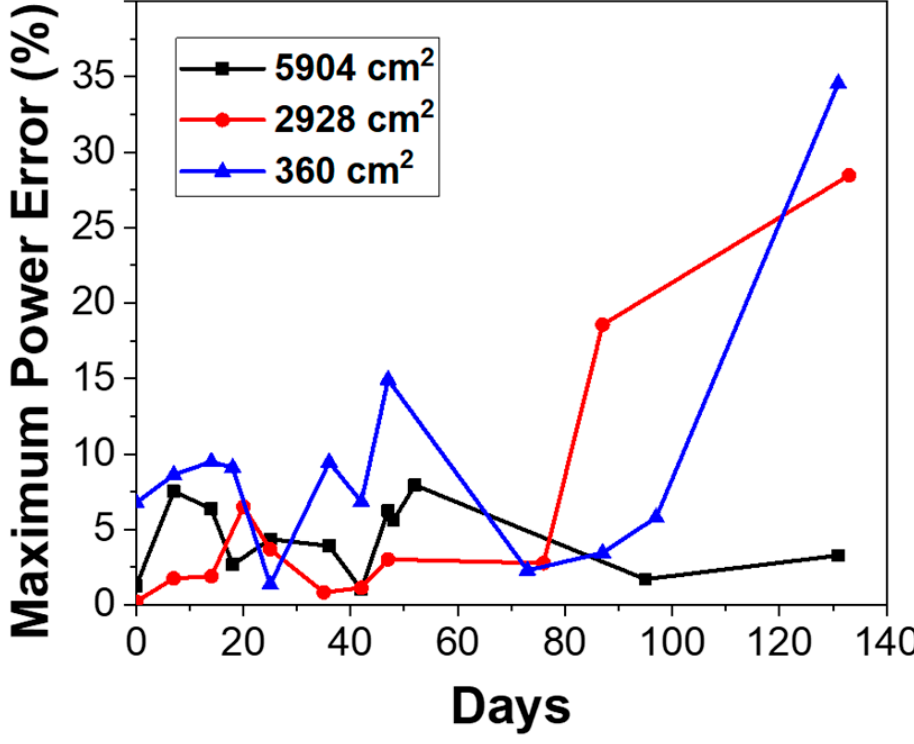
Figure 9. Maximum power errors between simulation results and measurements.